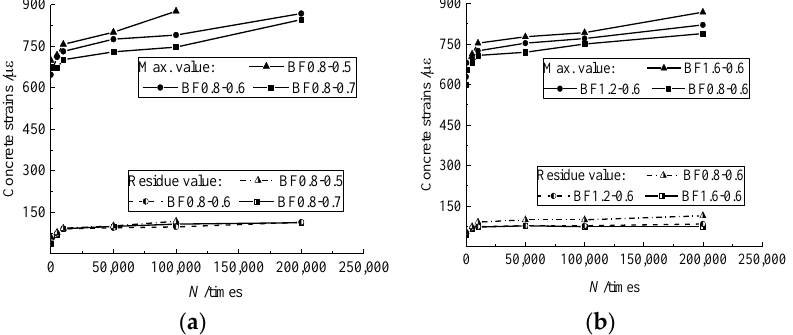
Figure 6. Changes of compressive strain at the top-surface of the mid-span section affected by: ( a ) α h ; and ( b ) v f .